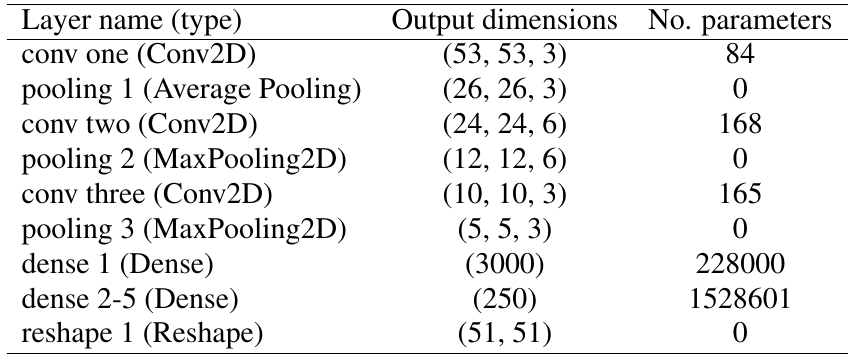
Table 3: Keras summary data for the CNN showing topology and modifiable